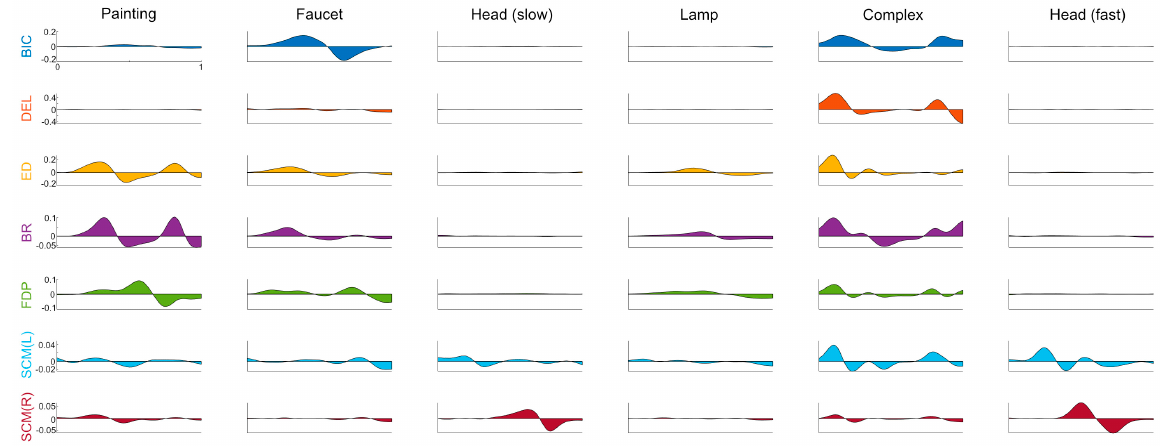
Figure A2. Complete EMG traces. Rate of change of muscle activation during the task recorded from 7 different EMG channels, by task, averaged across participants, task duration normalized. Each column represents a task: painting, faucet, head (slow), lamp, complex, head (fast). Each row represents a bipolar EMG channel, recorded from the following muscles: biceps, deltoid, extensor digitorum, flexor digitorum profundus, sternocleidomastoid (left, right).